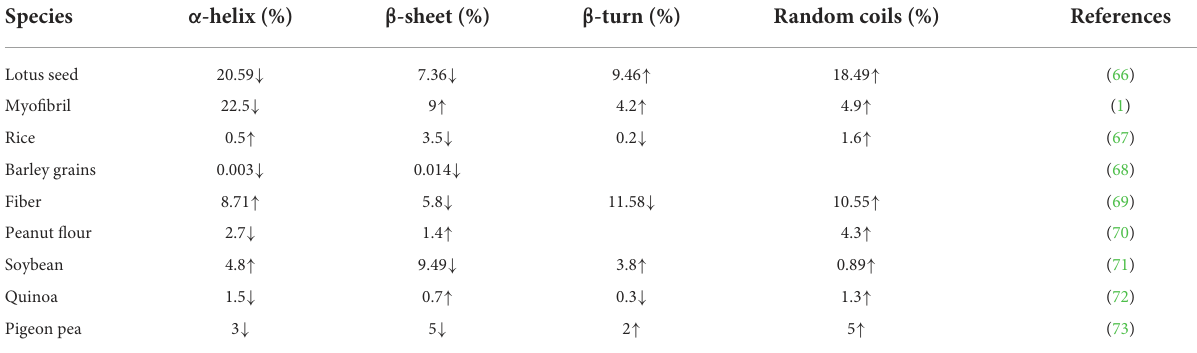
TABLE 5 Effect of microwave treatment on protein structure in